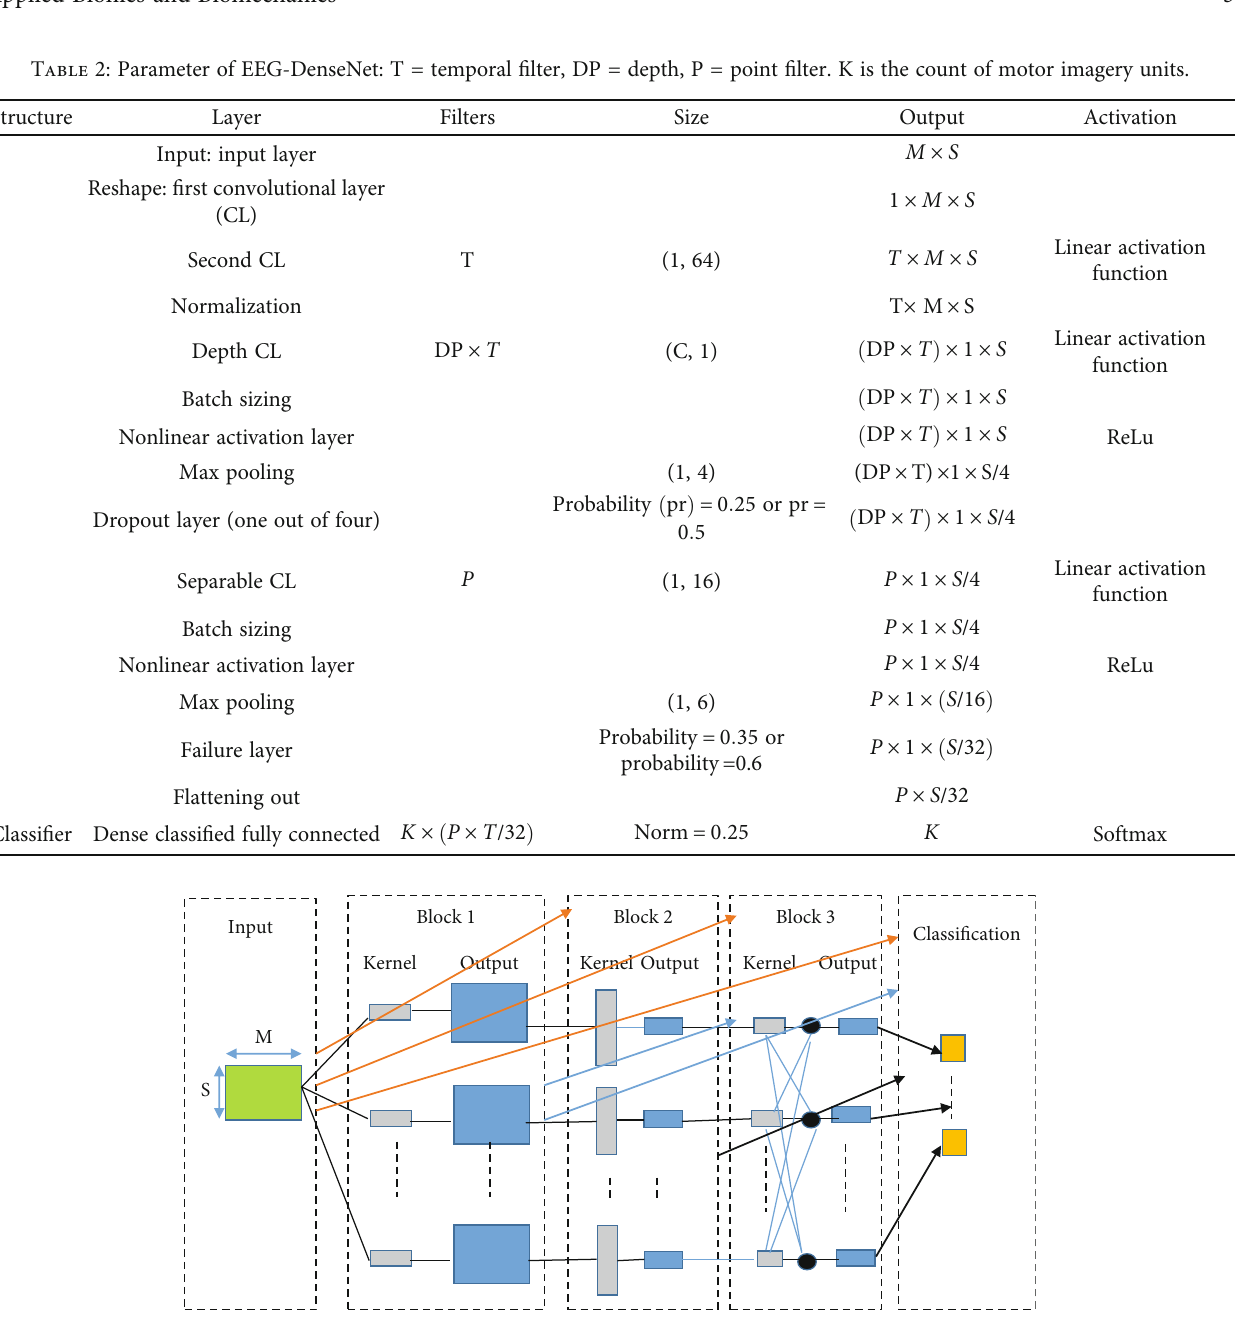
Figure 2: EEG-DenseNet